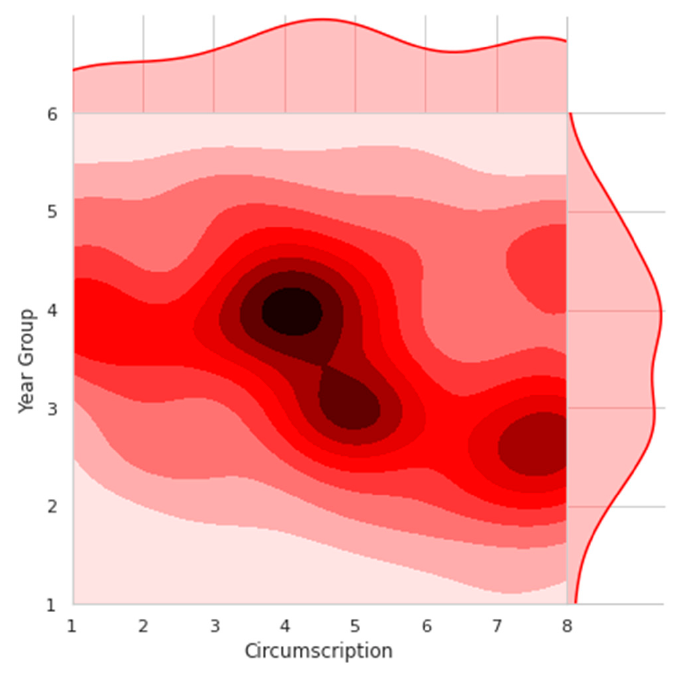
Figure 17. Heatmap of Jointplot of predicted interventions grouped by circumscription.